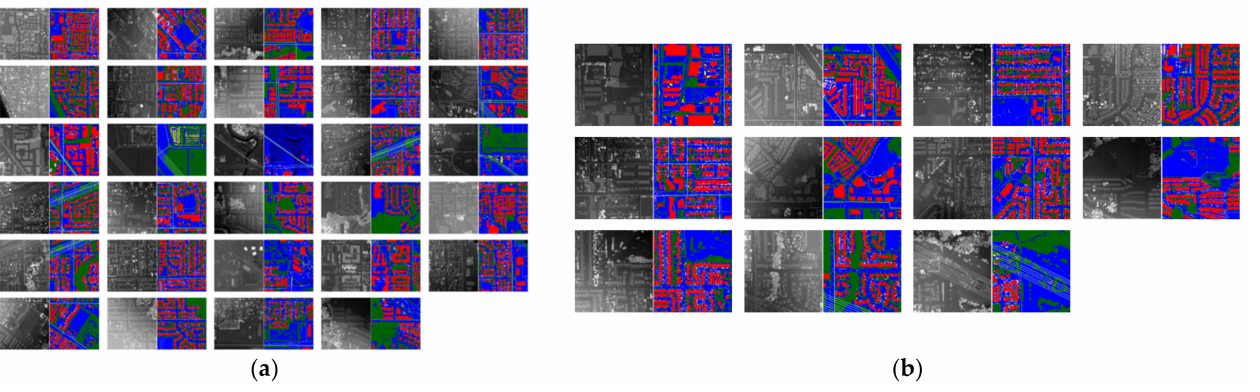
Figure 3. LiDAR data and semantic segmentation labels of DALES datasets: ( a ) training datasets; ( b ) test